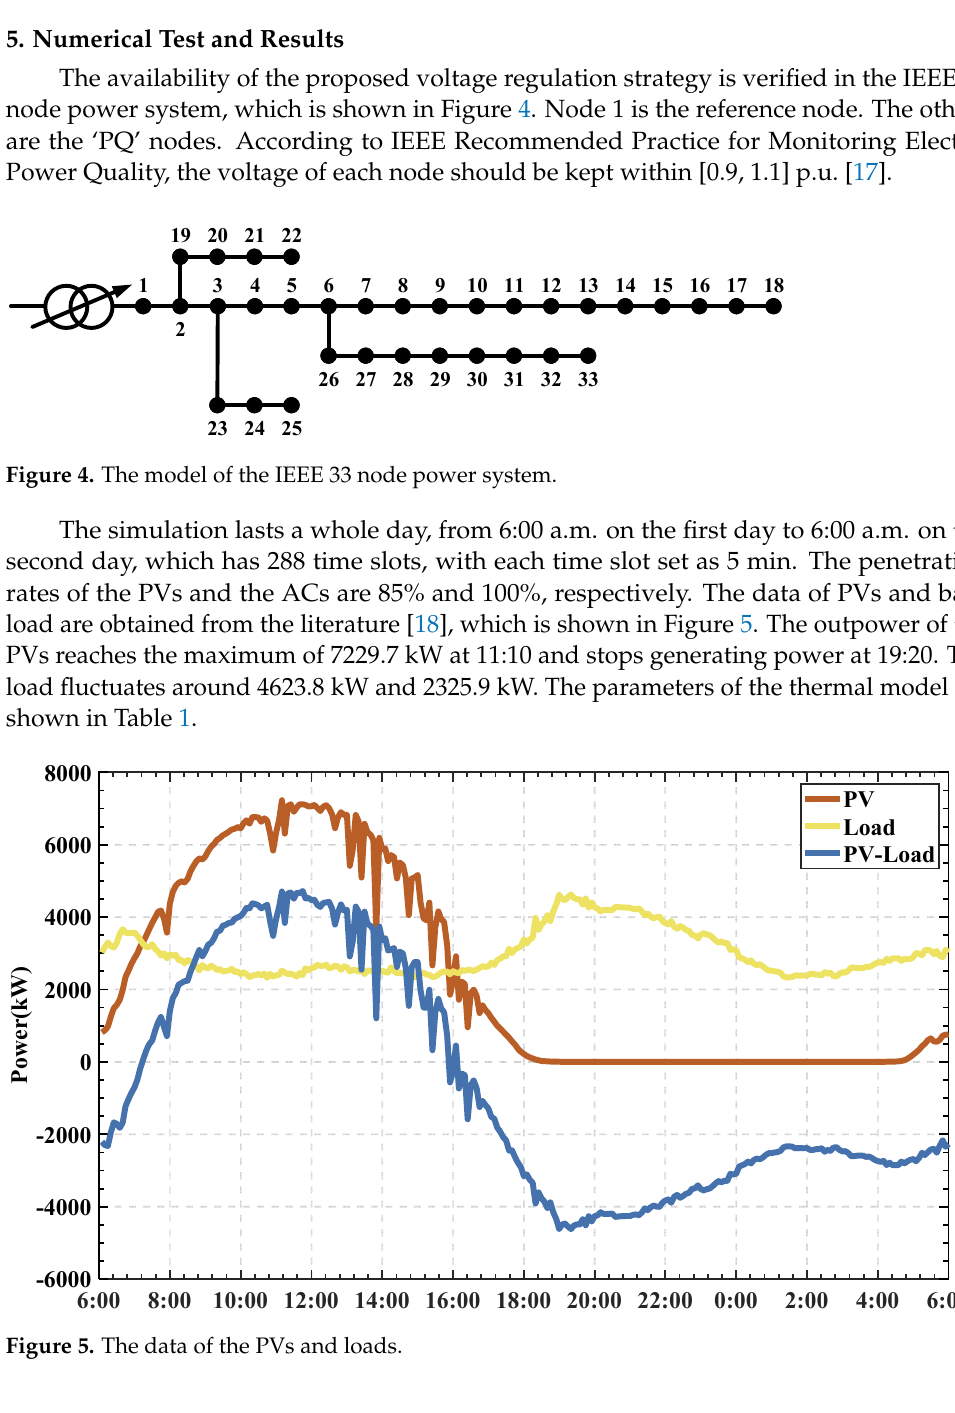
Figure 3. The classification process of the ACs.